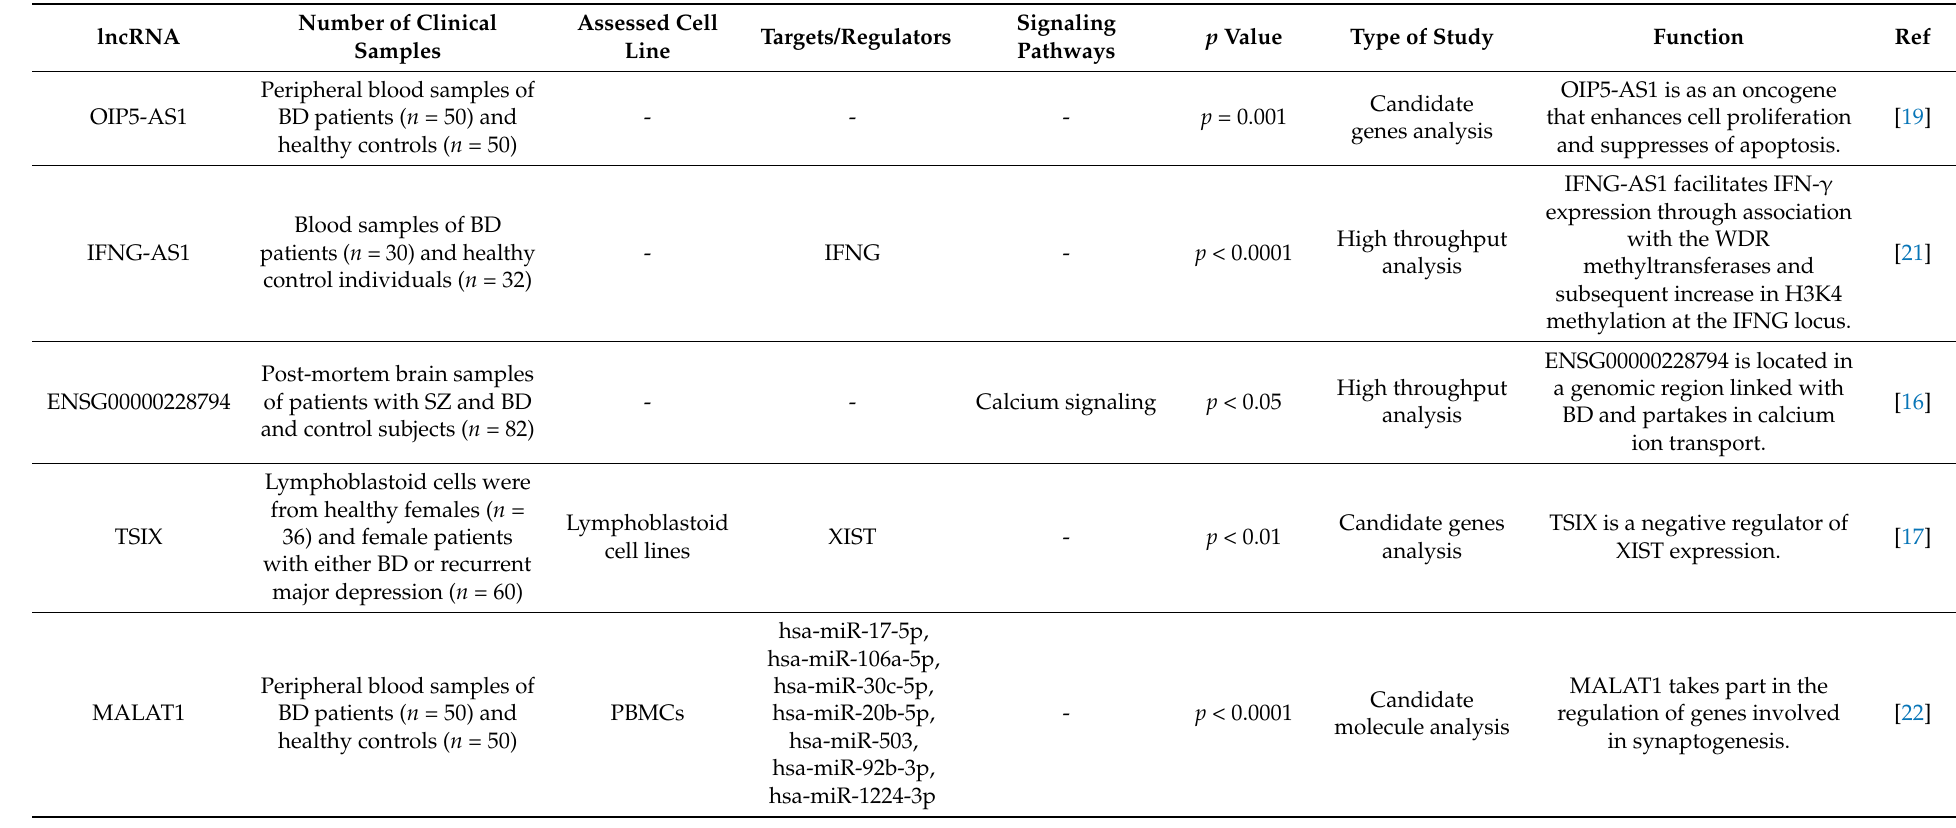
Table 4. Summary of function of down-regulated lncRNAs in BD (BD: bipolar disorder, SZ: